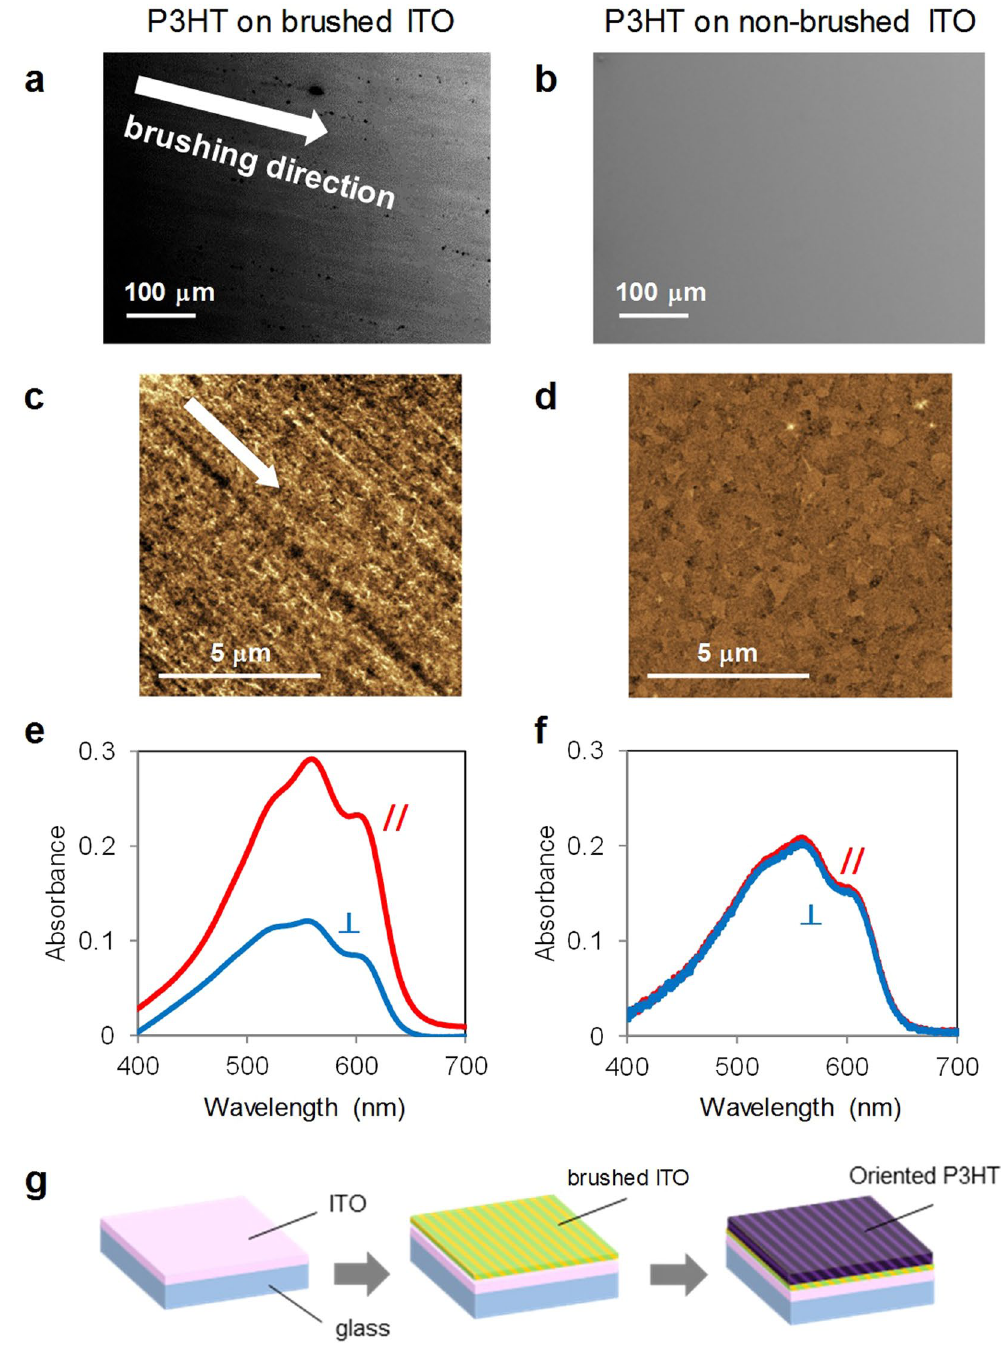
Figure 3. SEM images of P3HT thin films on ( a ) brushed and ( b ) non-brushed substrates. AFM images of P3HT thin films on ( c ) brushed and ( d ) non-brushed substrates. Polarized absorption spectra of P3HT films on ( e ) brushed and ( f ) non-brushed substrates. Red and blue spectra were obtained using incident light polarized parallel (//) and perpendicular ( ⊥ ) to the brushing direction, respectively. ( g ) Schematic illustration of sample